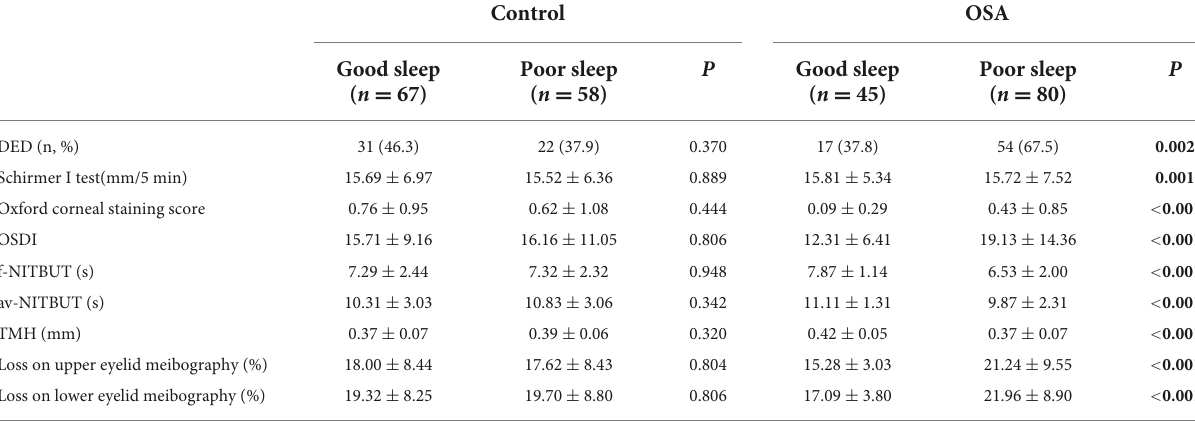
TABLE 4 Dry eye disease (DED)-related parameters in good and poor sleep groups of OSA cases and relevant controls.